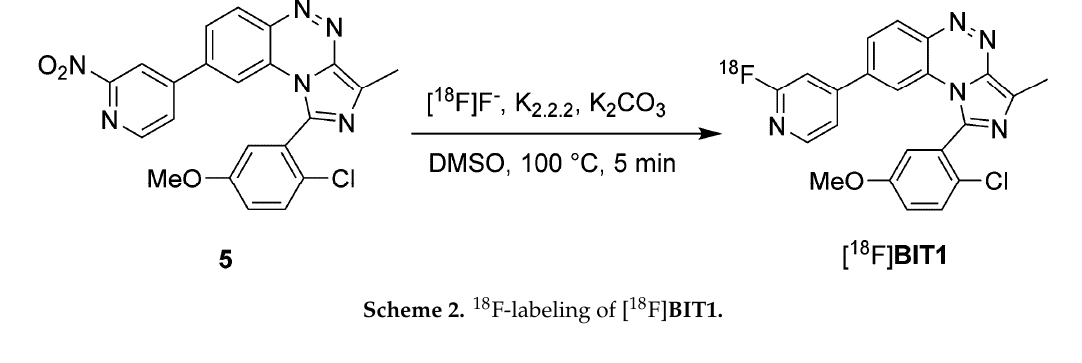
Scheme 2. 18 F-labeling of [ 18 F]